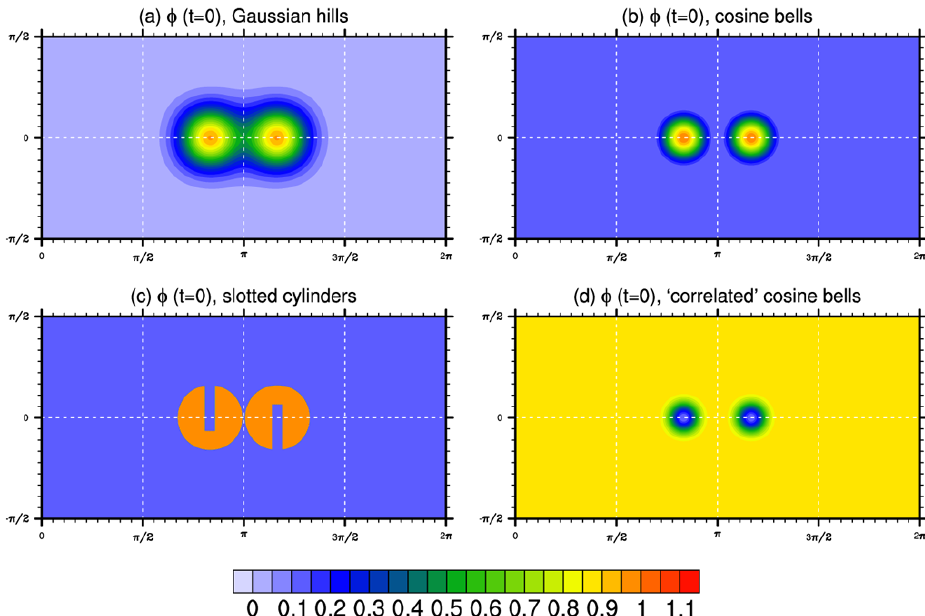
Fig. 1. Contour plots for the four initial conditions for mixing ratio φ . (a) depicts the infinitely smooth ( C ∞ ) initial condition constructed from Gaussian surfaces, (b) the cosine bells initial condition which is C 1 , (c) the non-smooth slotted cylinders initial condition, and (d) is the initial condition, which is nonlinearly correlated with (b)